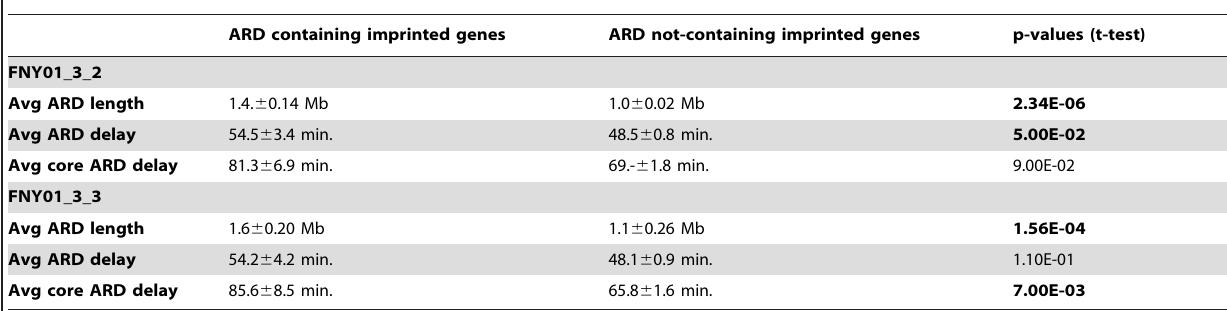
Table 2. Comparison of ARD containing and not containing imprinted genes.